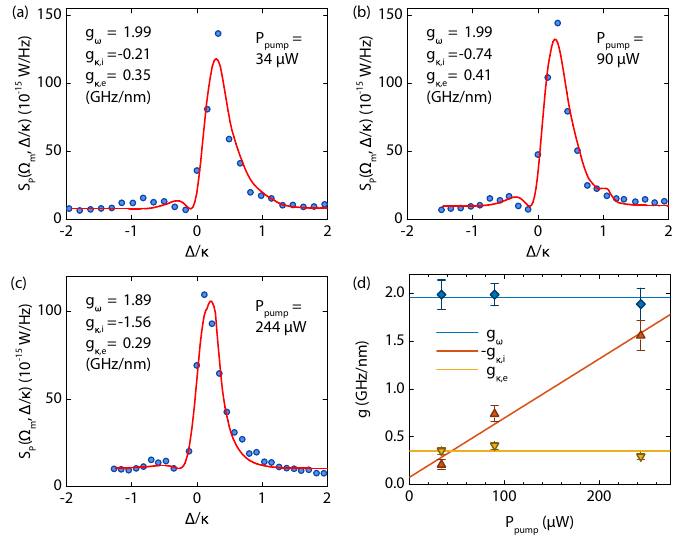
Figure 4. ( a – c ) Power spectral densities at mechanical resonance (circles: experimental data; solid lines: fit to model [6]) S P ( Ω m , ∆ / κ ) and fitted relative contributions of coupling dispersive ( g ω ) and dissipative (intrinsic g κ ,i and external g κ ,e ) coupling strengths for different powers of non-resonant pump; ( d ) Experimental evolution of the optomechanical coupling coefficients with the power of the external non-resonant pump (markers—data from ( a – c ), solid lines—linear